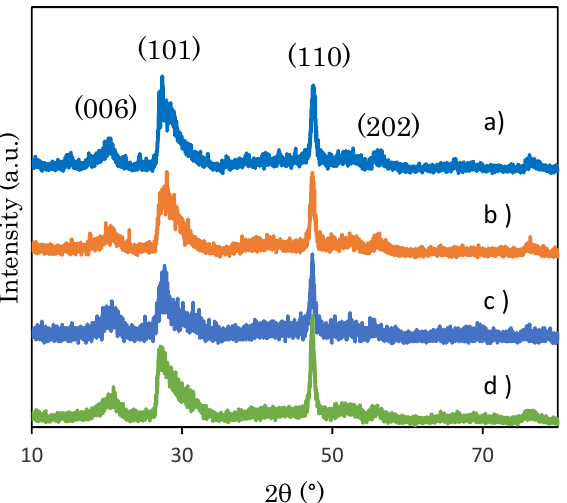
Figure 1. XRD patterns of ( a ) ZnIn 2 S 4 , ( b ) Zn 0.87 In 2 S 3.87 , ( c ) Zn 0.87 Cu 0.13 In 2 S 3.935 and ( d ) Zn 0.74 Cu 0.13 In 2 S 3.805